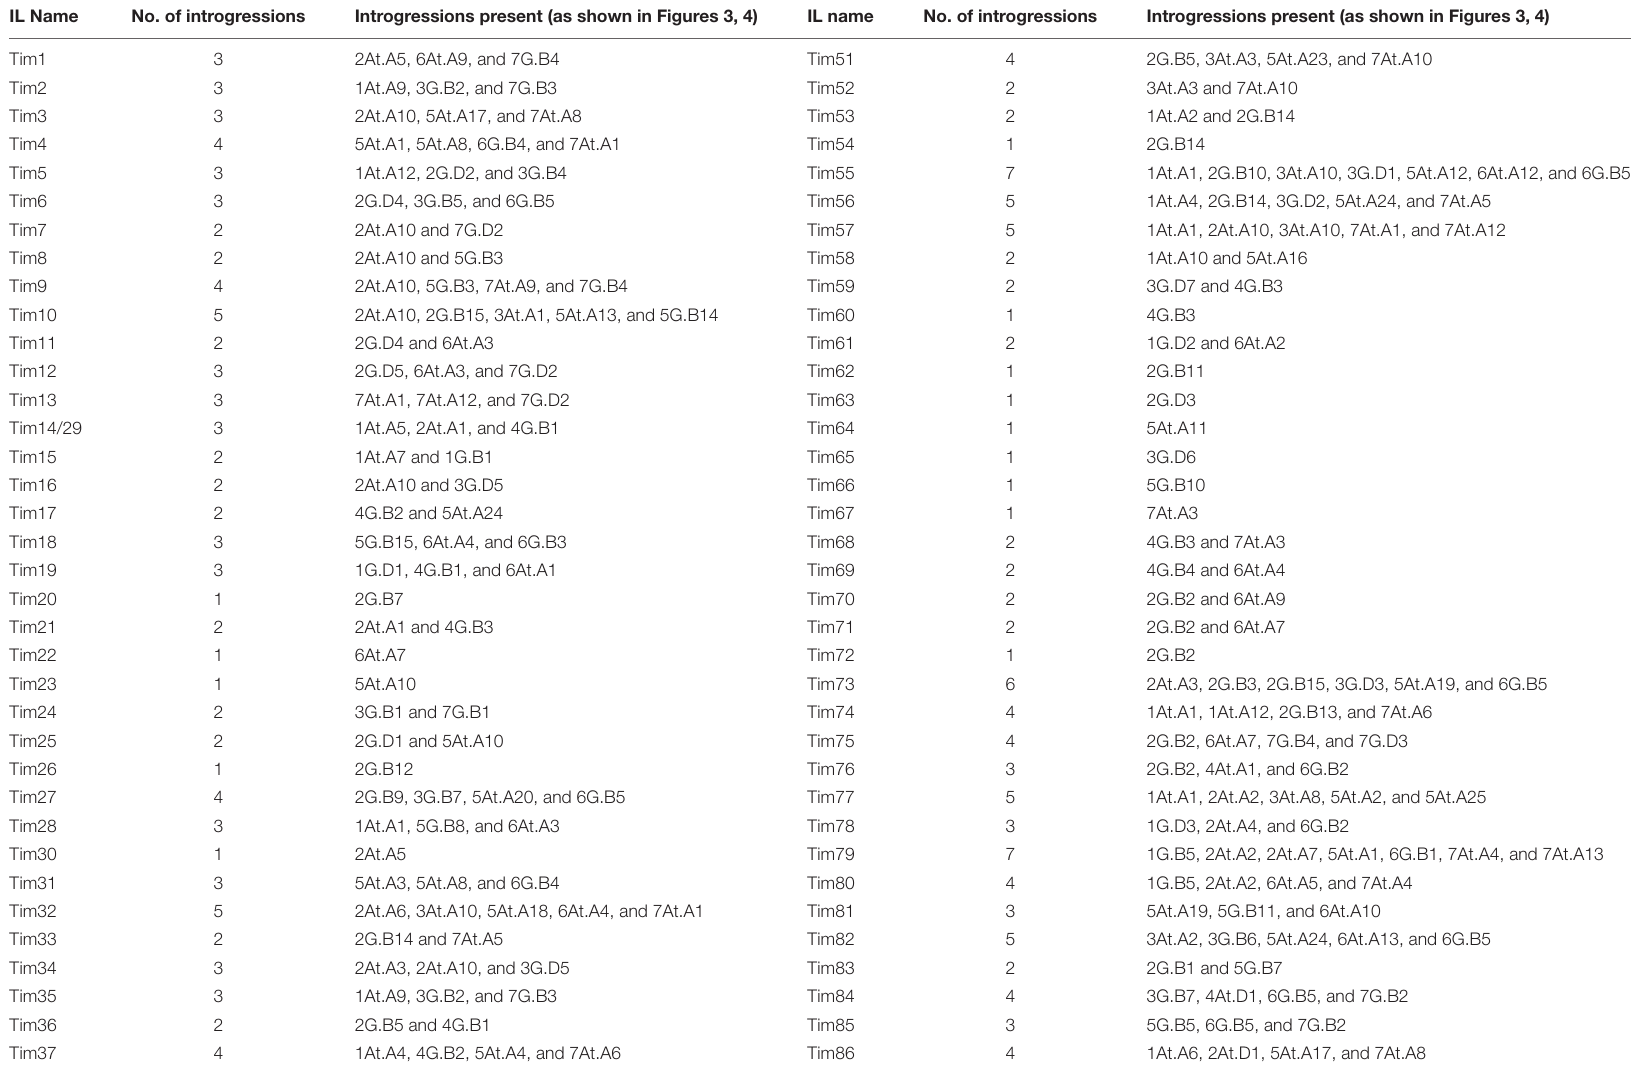
TABLE 2 | Number and description of Triticum timopheevii introgressions present in each wheat- T. timopheevii introgression line (IL), corresponding to the segments depicted in Figures 3 , 4